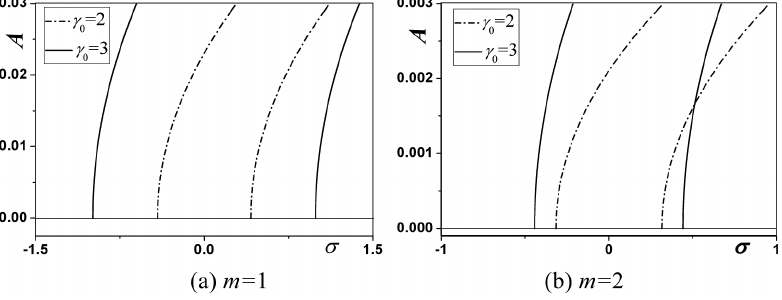
Fig. 3. Effects of the mean axial speed: Eq. (15).